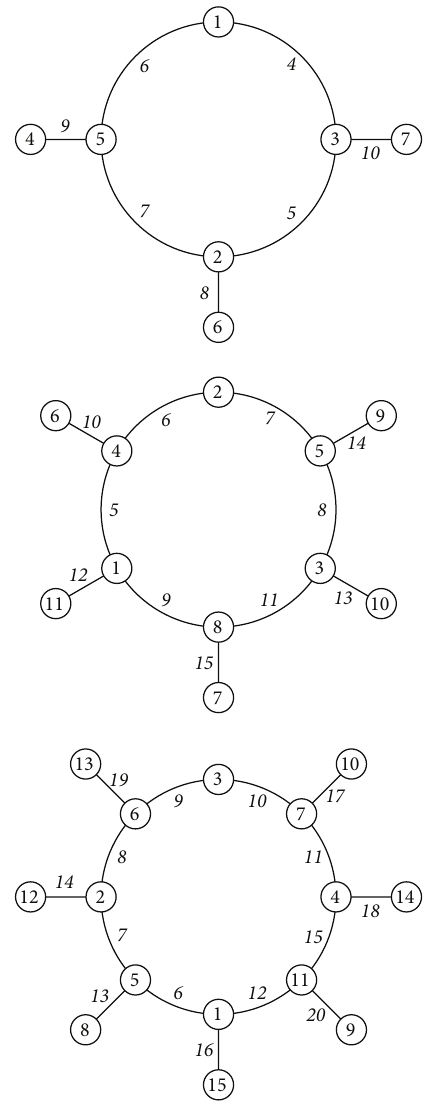
Figure 2: The (𝑎, 1) -EAV labelings for the graphs obtained from a crown graph 𝐶 𝑛 ⊙ 𝐾 1 by removing one pendant edge for 𝑛 = 4, 6, 8 . The edge-weights under the corresponding labelings are depicted in